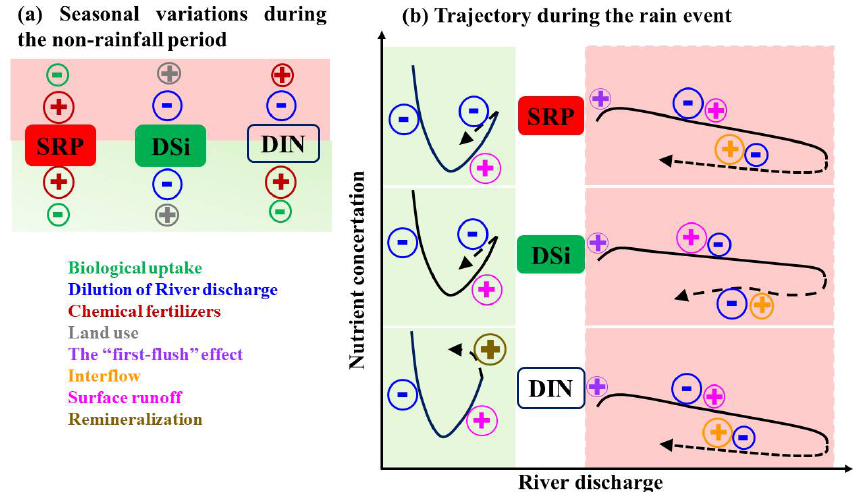
Figure 9. A conceptual diagram for the mechanisms controlling nutrient dynamics during ( a ) the non-rainfall period and ( b ) the rain event. The red and green shading in ( a , b ) represent the NS and WS, respectively. The solid and dotted lines in ( b ) represent the rising and falling limbs of the hydrograph, respectively.